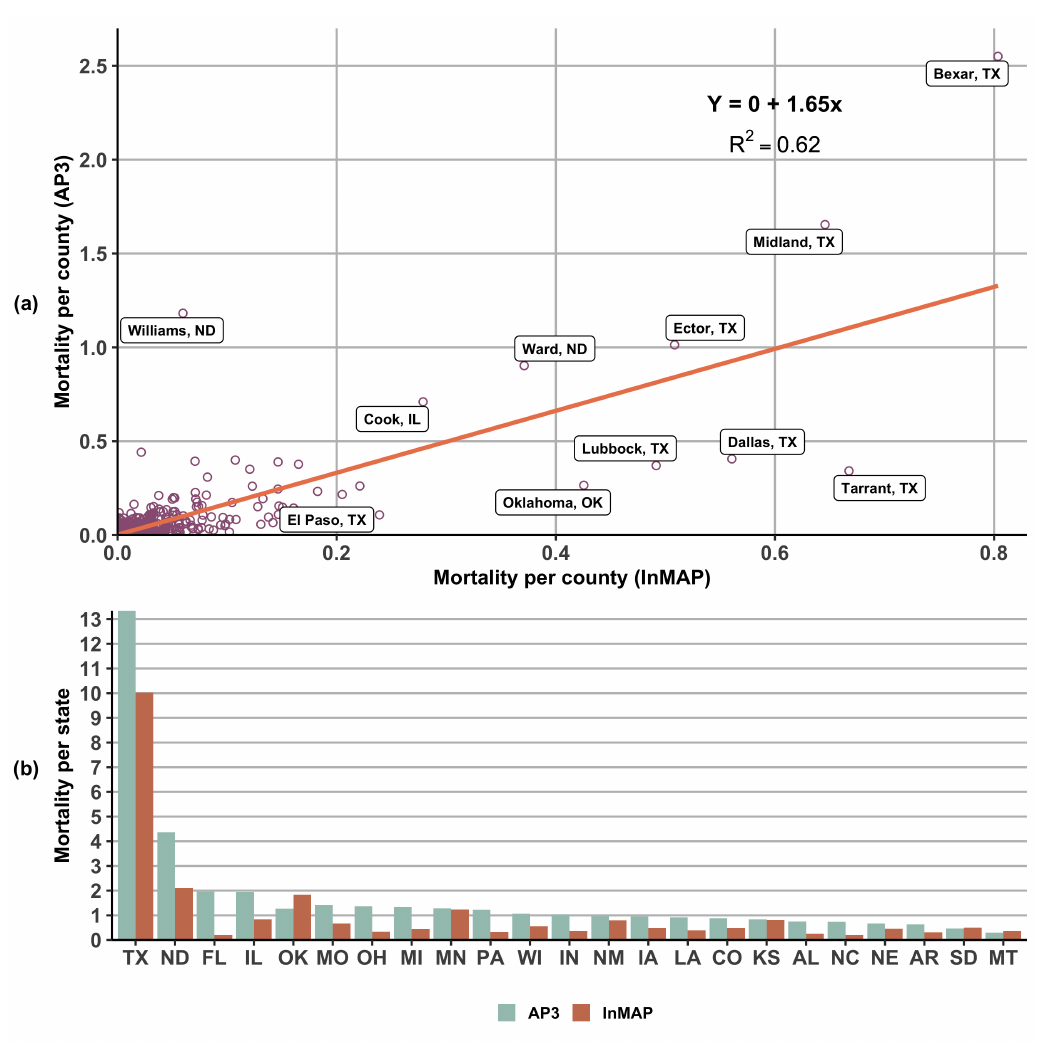
Figure 5. AP3 and InMAP simulations of flaring induced mortalities based on location of impacted population, plotted by ( a ) county and ( b ) state. Line in ( a ) assumes a linear fit and zero intercept. Table 3. BenMAP-CE estimates of morbidity caused by US flaring BC emissions in 2019, based on PM 2.5 contributions modeled by AP3 and InMAP and dose-response relationships from cited